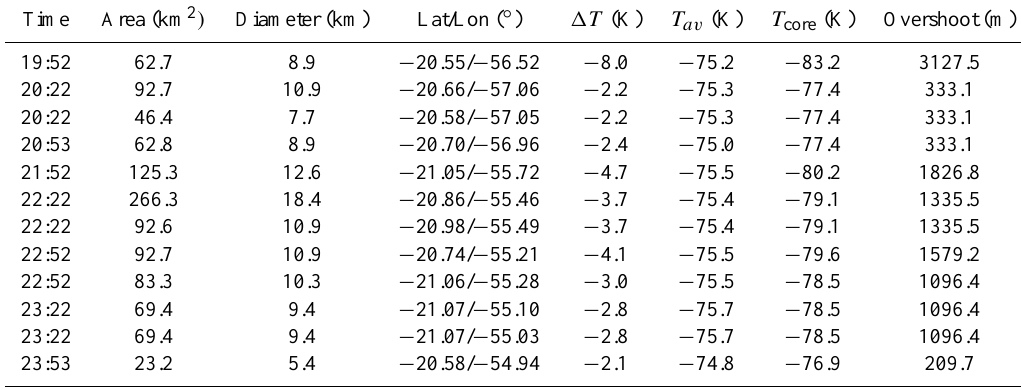
Table 2. Convective core characteristics for Region 1, 30 September–1 October